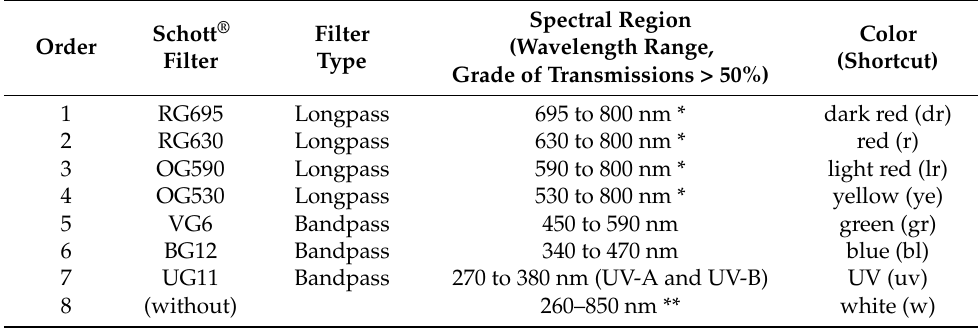
Table 1. Colored glass filters used for excitation, and their specifications (filter type and spectral region of